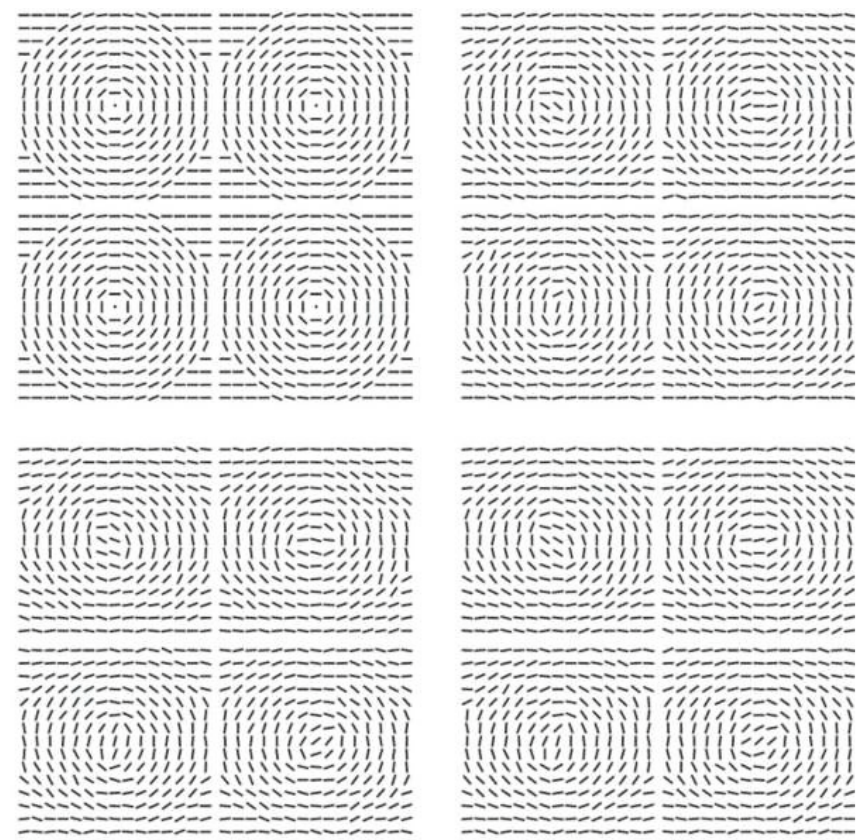
Figure 1: Spin configurations in different “horizontal” planes for the cell with thickness L = 10: k = 0, bottom control plane with circular defects (top left), k = 3 (top right), k = 4 (bottom left), and k = 5, middle of the cell (bottom